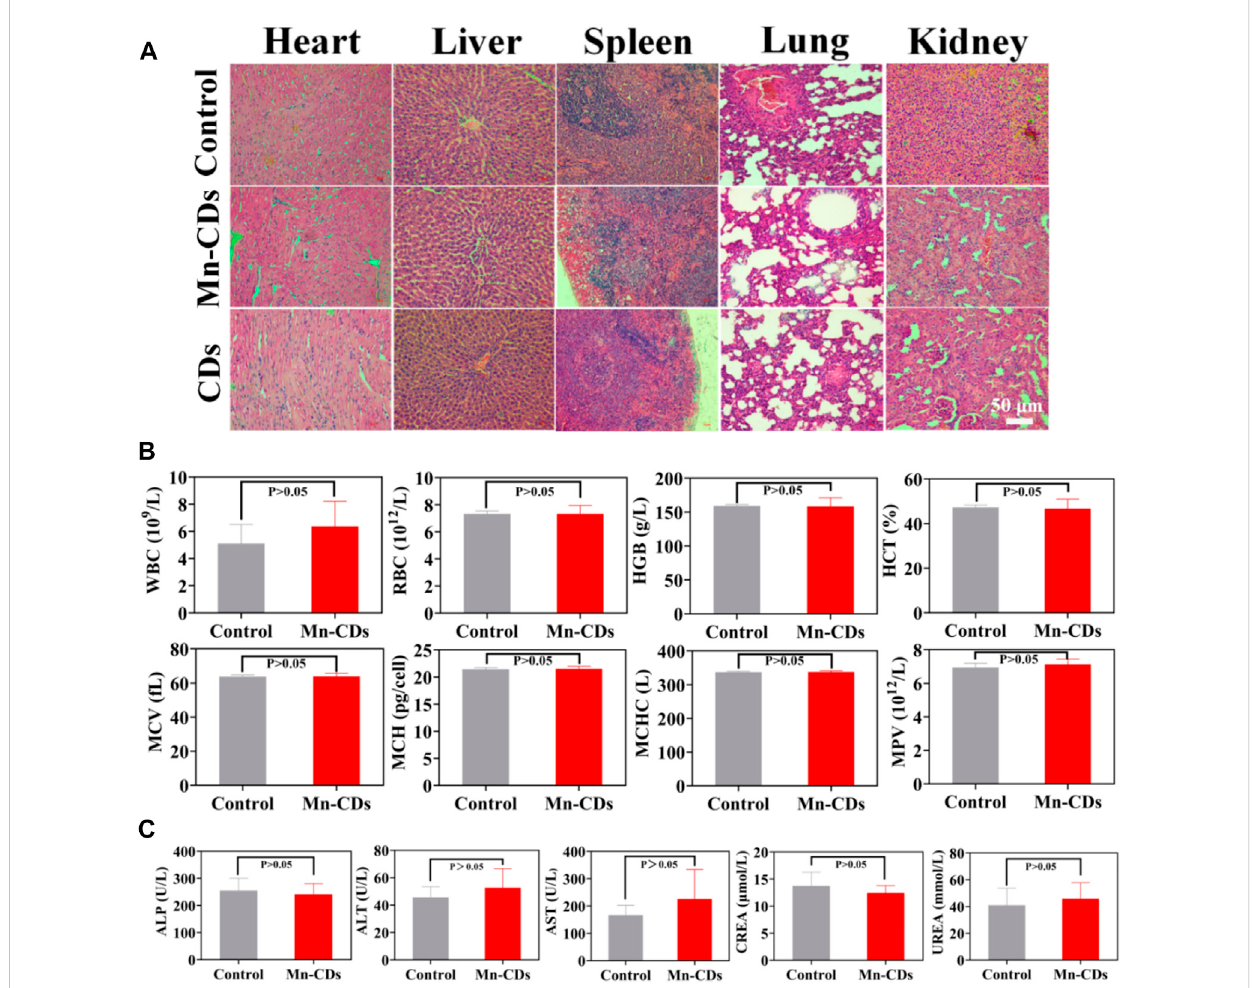
FIGURE 4 In vivo biosafety of Mn-CDs and CDs. (A) H&E staining of major tissues from SD rats after different treatments. (B) Blood routine examination of rats treated with PBS and Mn-CDs (10 mgkg − 1 ). (C) Blood biochemical analysis of ALT, AST, ALP, UREA and CREA after injection of PBS and Mn-CDs (10 mgkg − 1 ) for 7 days ( n =